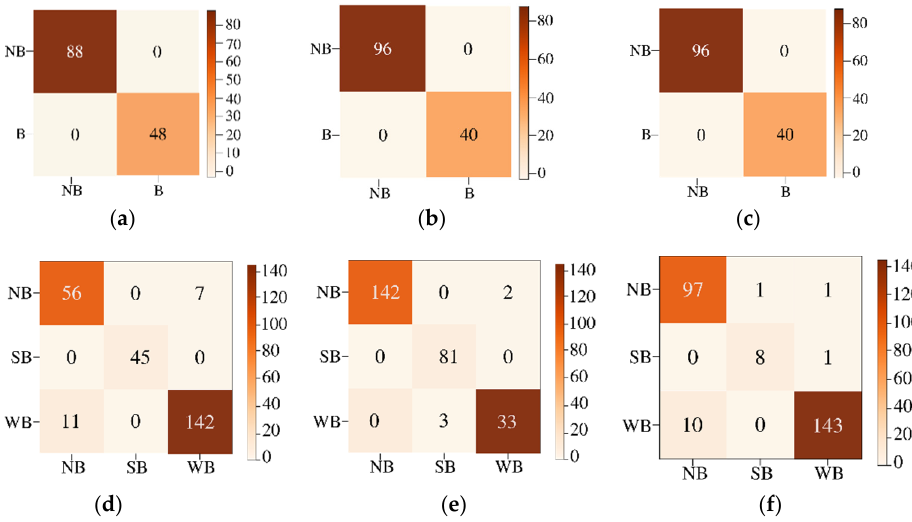
Figure 15. The confusion matrices for 2 labels Not Belong (NB) and Belong (B) given to the ( a ) trees, ( b ) water, and ( c ) soil pixels of the Jasper HSI in the top row. Bottom row shows the confusion matrices for 3 labels Strong Belong (SB), Weak Belong (WB), and Not Belong (NB) given to the ( d ) trees, ( e ) water and ( f ) soil pixels of the Jasper HSI.